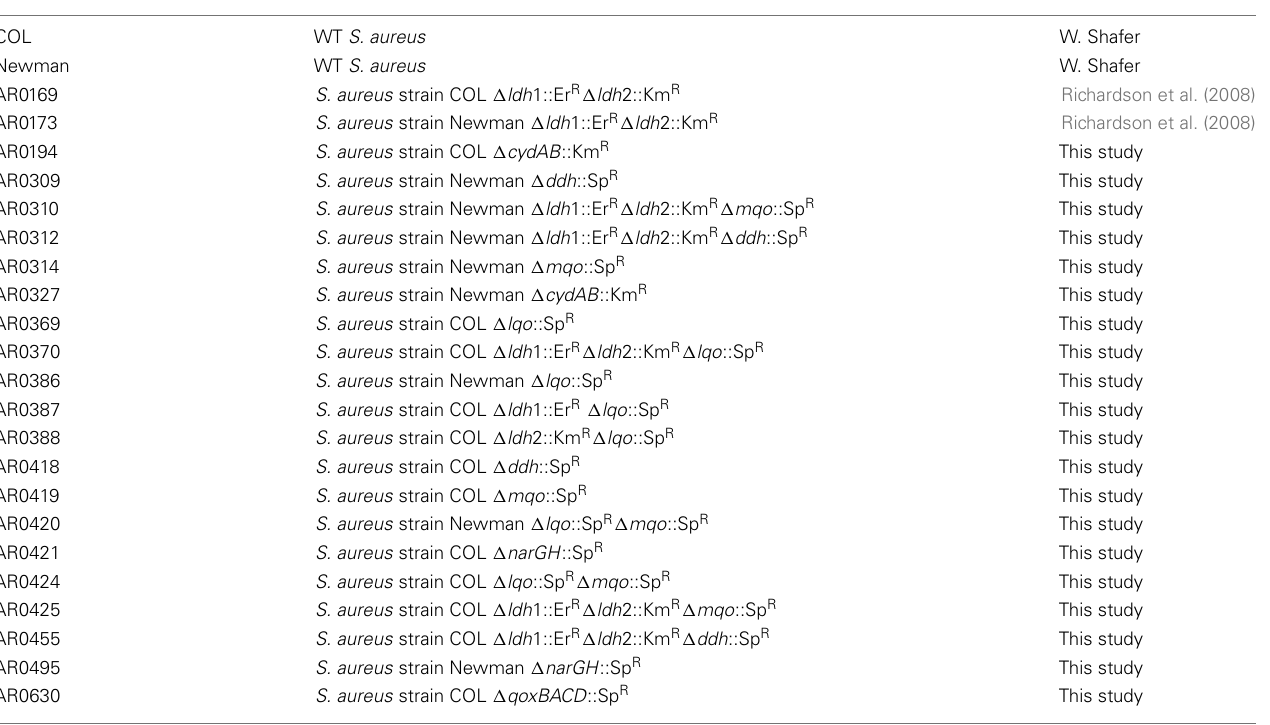
TableA1 | Strains used in this work.